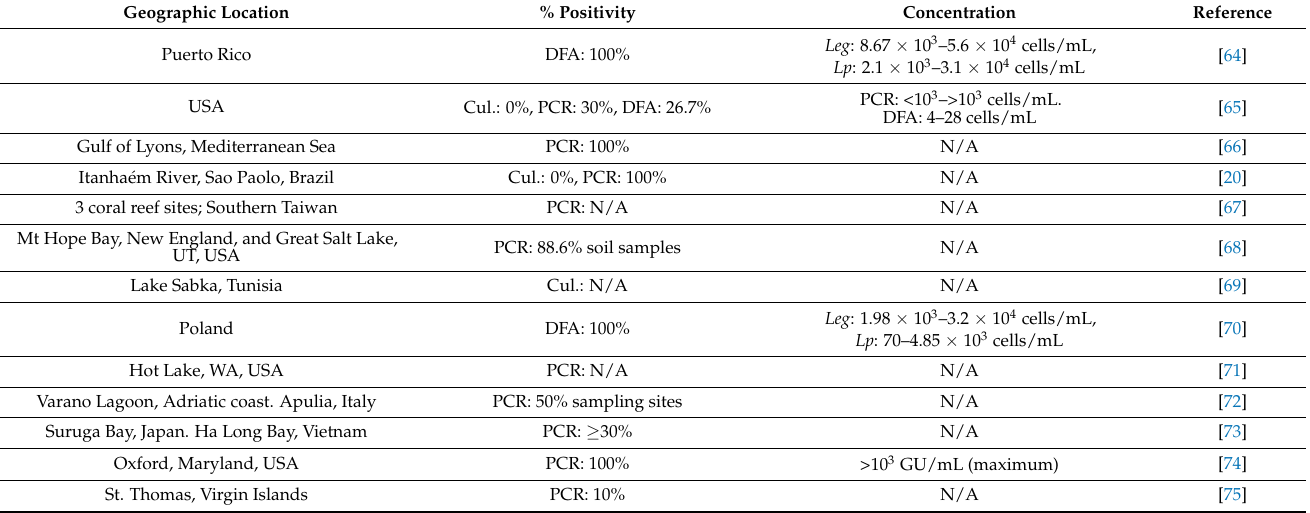
Table 3. Occurrence of Legionella in